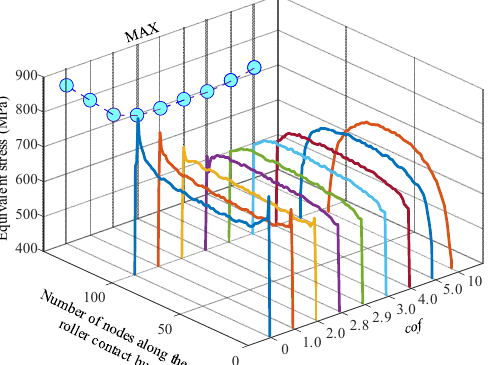
Figure 25. Stress distribution along the roller profile at different crowning parameter cof .